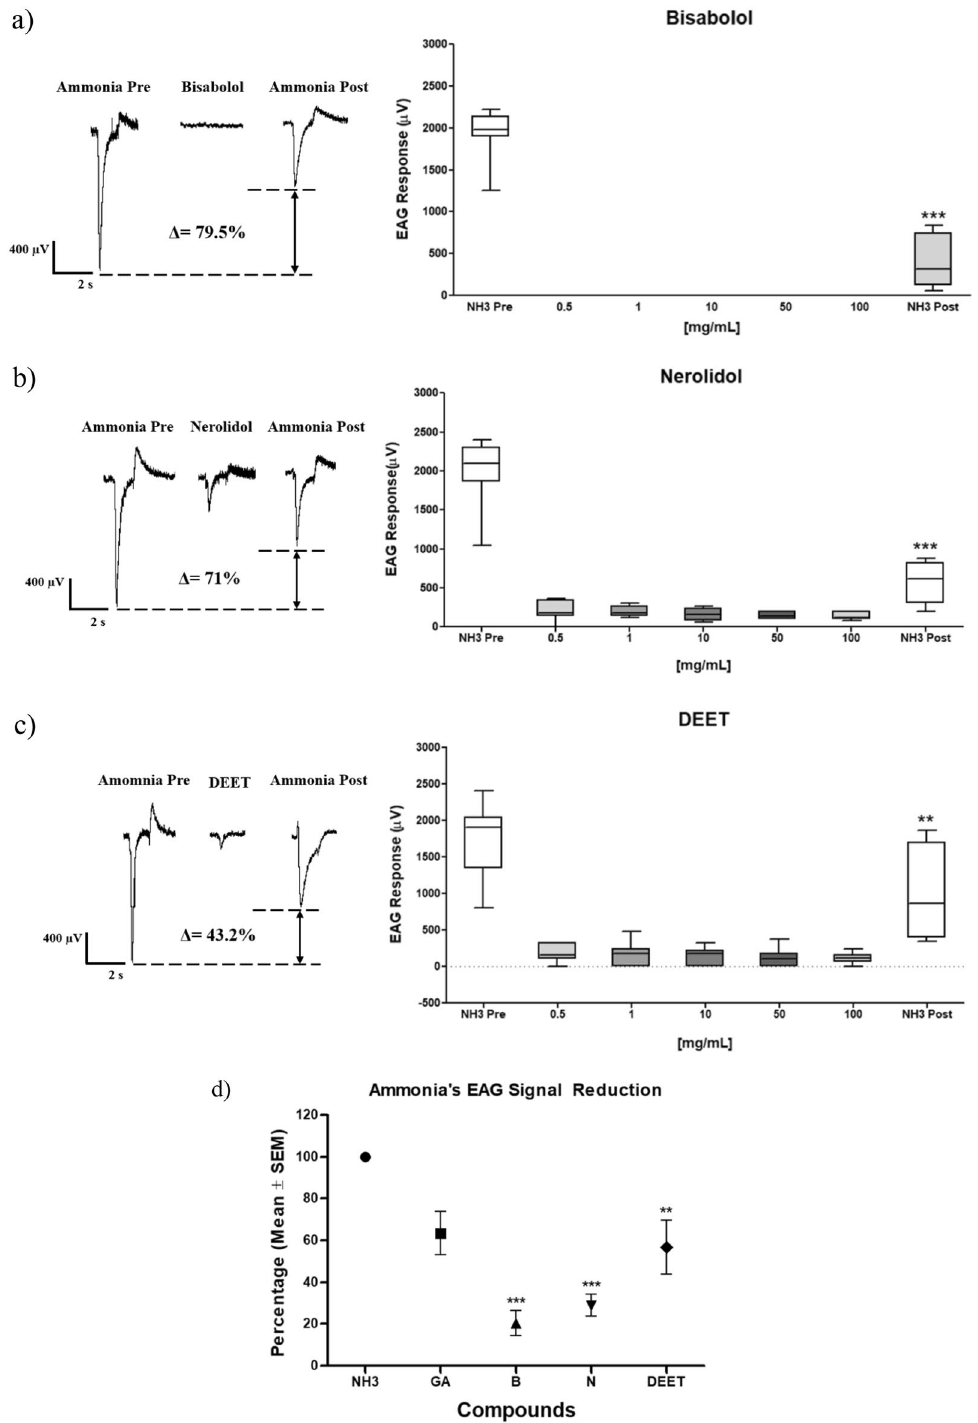
Figure 3. Electroantennography signals patterns and percentage changes in the post-treatment ammonia signals after applying the molecules, ( a ) α-bisabolol, ( b ) nerolidol y, ( c ) DEET in the concentrations 0.5, 1.0, 10, 50, and 100 mg/mL. For each experiment, a pre- and post- pulse of ammonia was applied. ( d ) Percentual reduction summary (average ± standard deviation SEM) of ammonia stimulus in the olfactory mosquito system after applying the repellent substances mentioned (NH3: ammonia, GA: Geranyl Acetate, B: α-bisabolol, N: nerolidol). (**) and (***) indicate statistically significant differences comparing the ammonia EAG signals pre- and post-treatment before and after applying the repellent molecules, respectively. One way ANOVA, (**) p < 0.01; (***) p < 0.001, post hoc Tukey